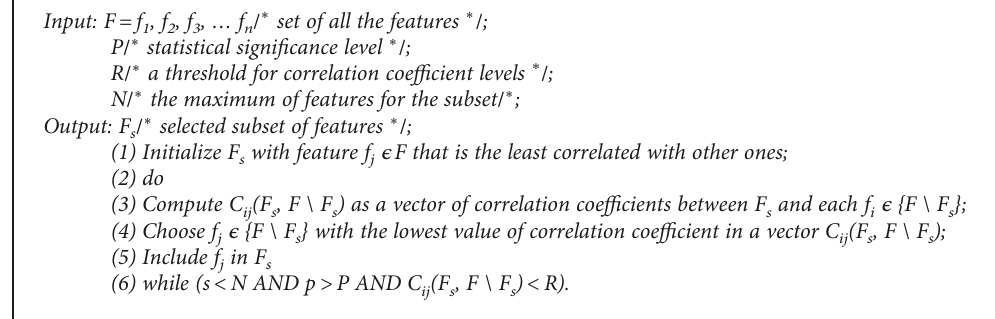
Algorithm 1: Proposed feature selection algorithm using reversed